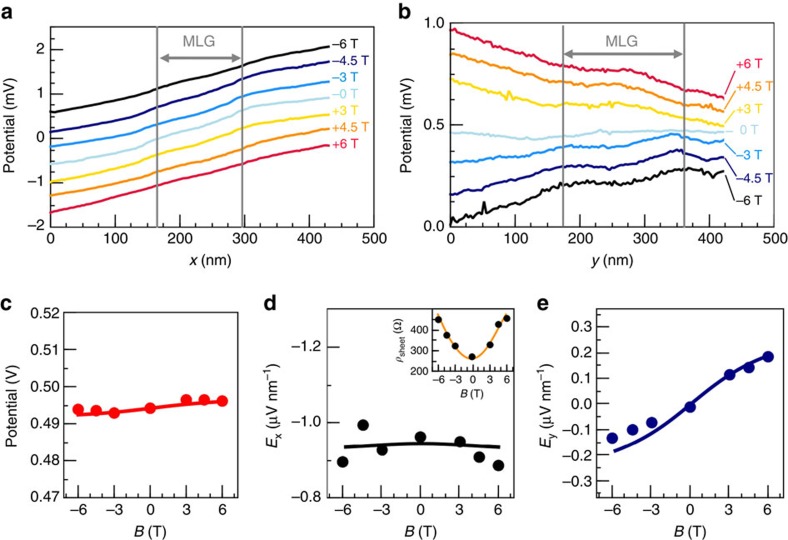
Hall measurements on the atomic scale.(a) Potential across the sample region shown in Fig. 1c in x direction (averaged in y direction) and (b) in y direction (averaged in x direction). Lines have been shifted relative to each other. (c) Average potential as a function of magnetic field. (d,e) Electric field components Ex and Ey as a function of magnetic field B derived by linear fits from the data in a,b. The lines are the results of the macroscopic finite-element simulation as shown in Fig. 1d at the precise position of the measurement (see Supplementary Note 3 and Supplementary Fig. 5). For comparison, the experimental electric fields are normalized to VTrans=1 V. The inset shows Ex/jx with the macroscopic sheet resistance (yellow, taken from Fig. 1b).